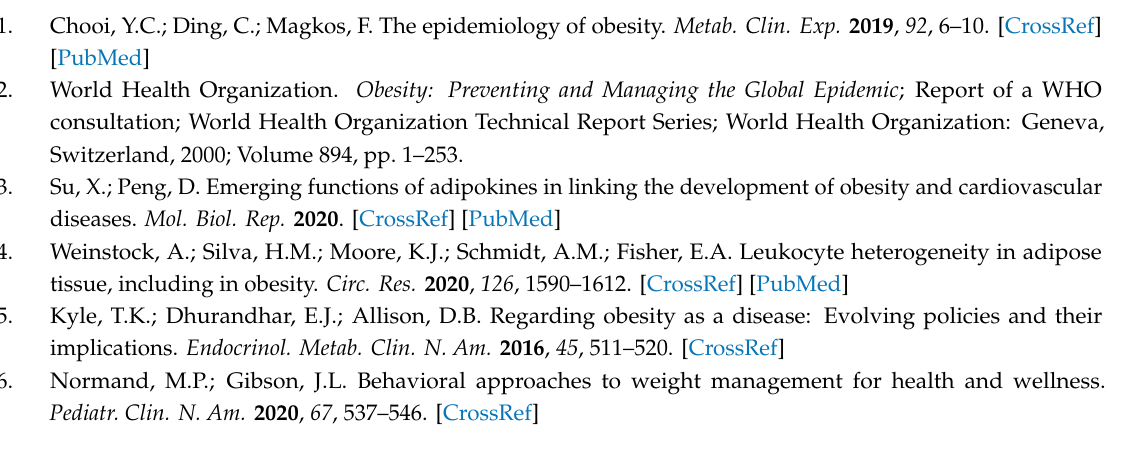
Figure S1. Gut bacteria in control subjects. Fecal samples from one hundred age- and sex-matched non-obese, normoglycemic, and normolipidemic voluntaries without known cardiovascular, malignant and digestive diseases were analyzed to estimate the control ranges for each bacteria. NGC / g: number of gene copies per gram of feces. Author Contributions: M.C.-Y. and T.H. processed and analyzed the fecal samples. M.G.-A. acquired